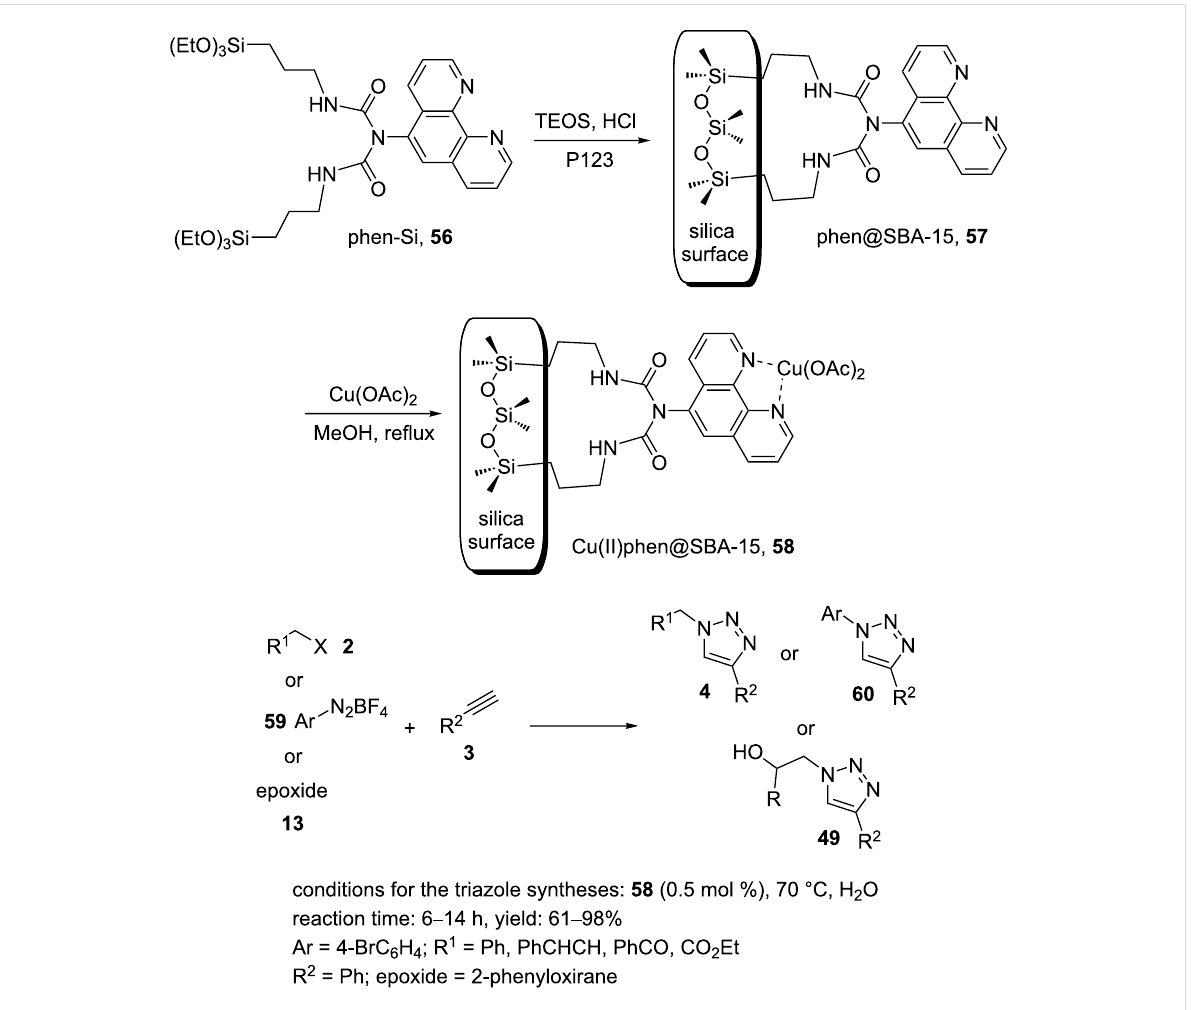
Scheme 9: Synthetic route to the catalyst 58 and catalytic application of 58 in “click”